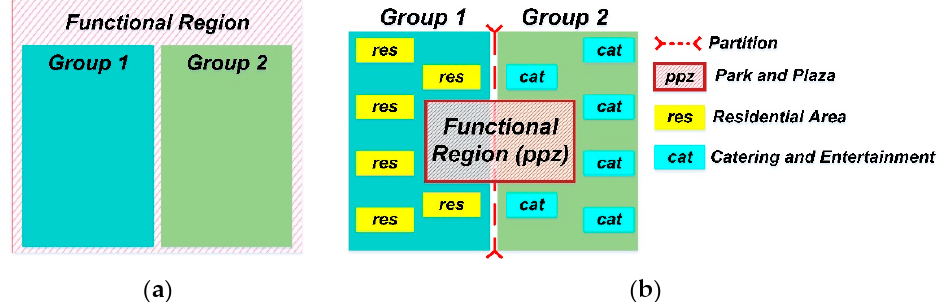
Figure 20. Illustration of relationship between parcel groups and functional region: ( a ) two groups merge into a large functional region; ( b ) hard segmentation. Table 6. Hard segmentation